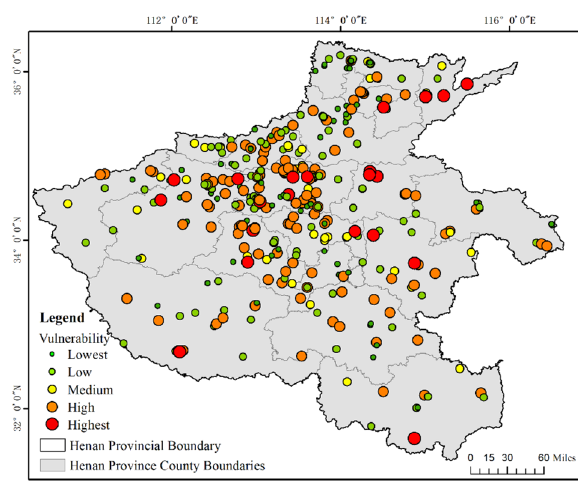
Fig. 3 Vulnerability assessment map of the nationally protected immovable cultural relics in Henan Province